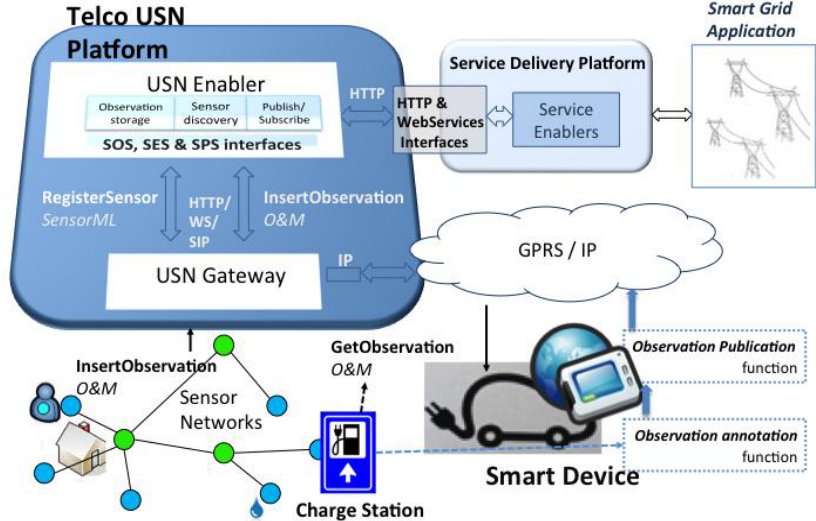
Figure 2. Integration of Smart Devices into a Telco